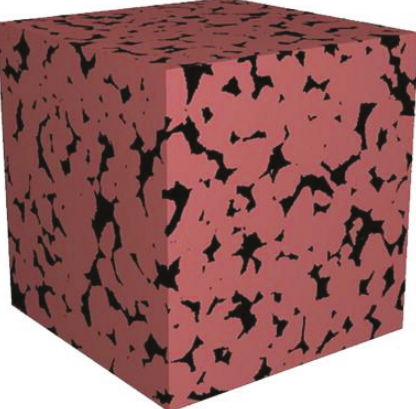
Figure 4: The Fontainebleau sandstone dataset with a binary segmentation. The red part is the skeleton; the black part is the pores. The total size of the dataset is 288 × 288 × 300 and a voxel edge length is 7.5 μ m. Figure from